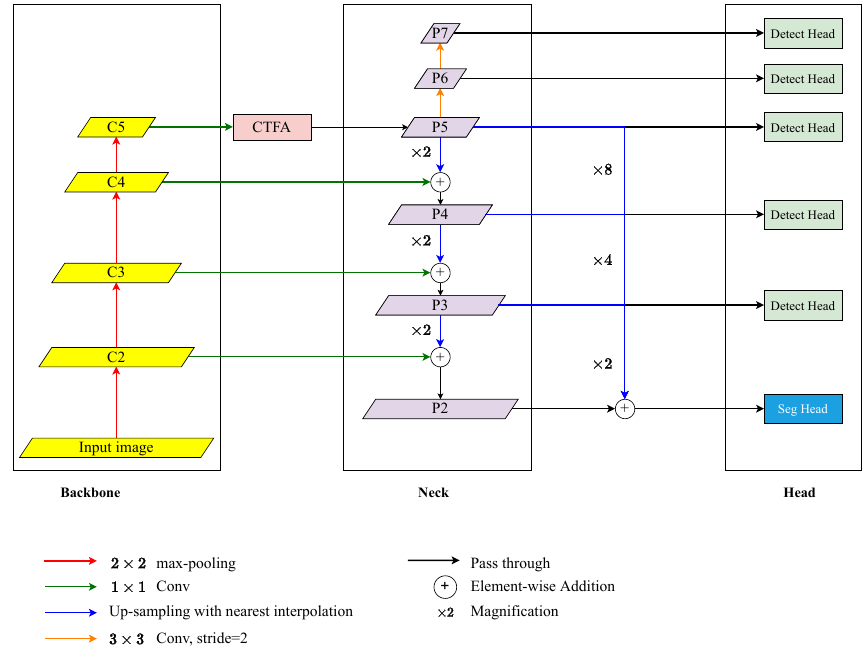
Figure 1. An overview of the proposed architecture for detecting the malposition. It consists of a ResNet-based backbone, Coarse-to-Fine Attention (CTFA), FPN-based neck, FCOS-based detection head, and segmentation head. The legends below demonstrate the operations